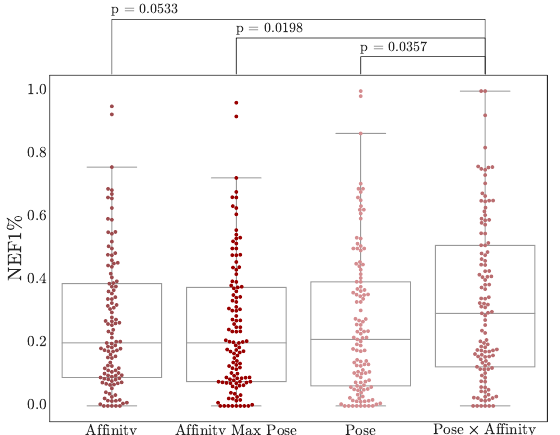
Figure 9. Early enrichment using score combinations. NEF1% performance of the Default ensemble on both DUD-E and LIT-PCBA targets is shown. The two-sided Mann-Whitney U rank test is used to compute p -values. Other metrics are shown in Figure